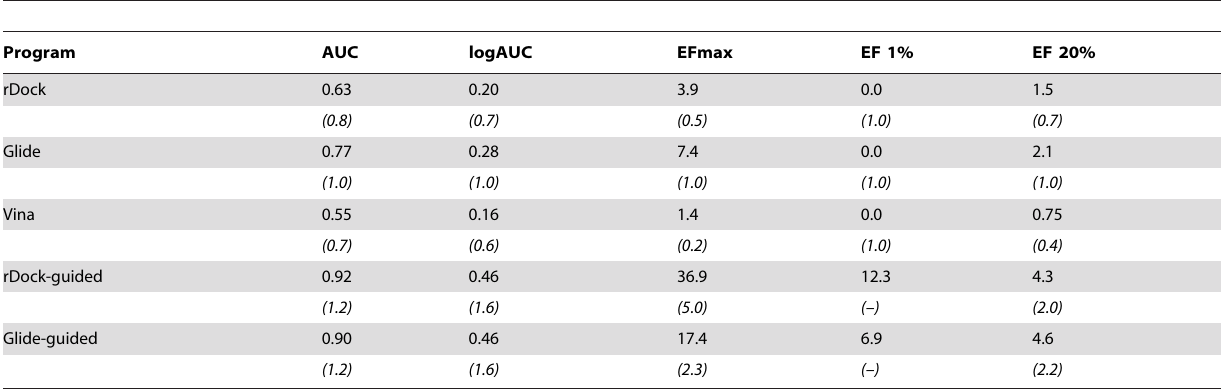
Table 5. VS performance metrics for Hsp90 using an unbiased protocol with default parameters (rDock, Glide & Vina) or an optimized cavity definition and empirical pharmacophoric restraints (rDock-guided & Glide-guided).